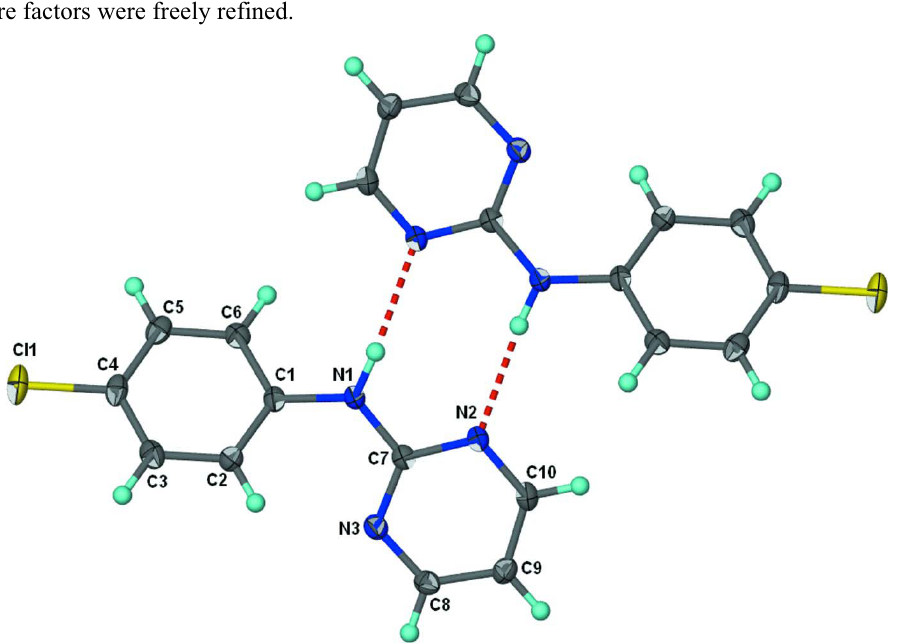
H ClN at the 70% probability level. 10 8 3